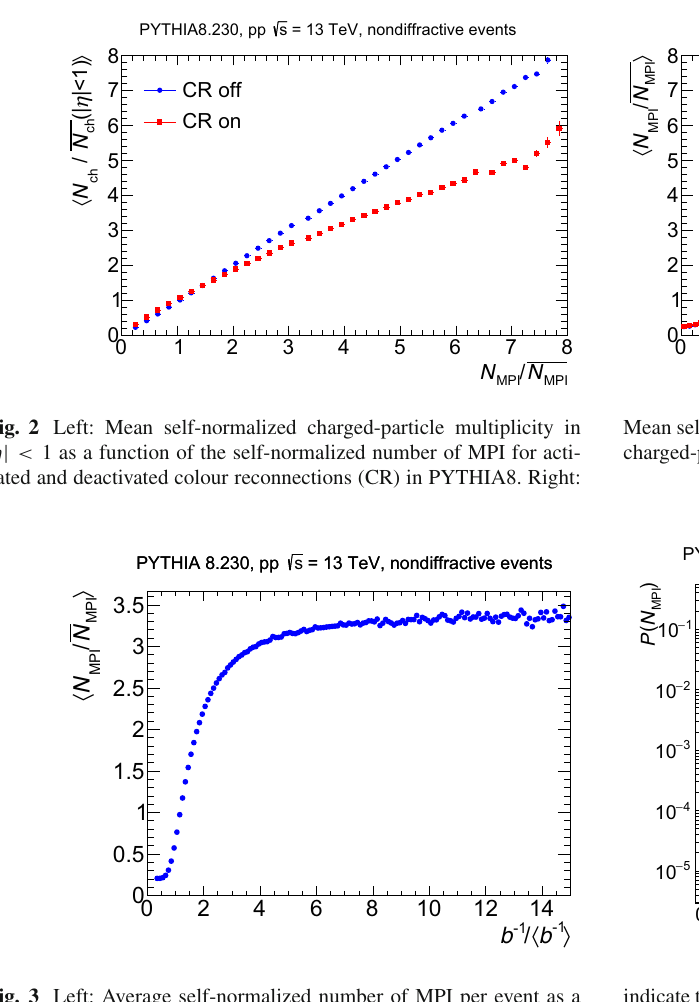
indicate the average and the change of slope at 3 . 3 N mpi , the maximum value achieved for ( b = 0) without statistical